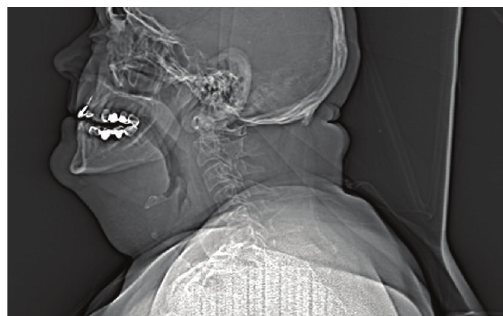
Figure 1: A scout CT view of the patient in case 2. This view shows a patent oropharyngeal airway despite superior and posterior displacement of the tongue secondary to a significant submandib- ular inflammation and swelling.